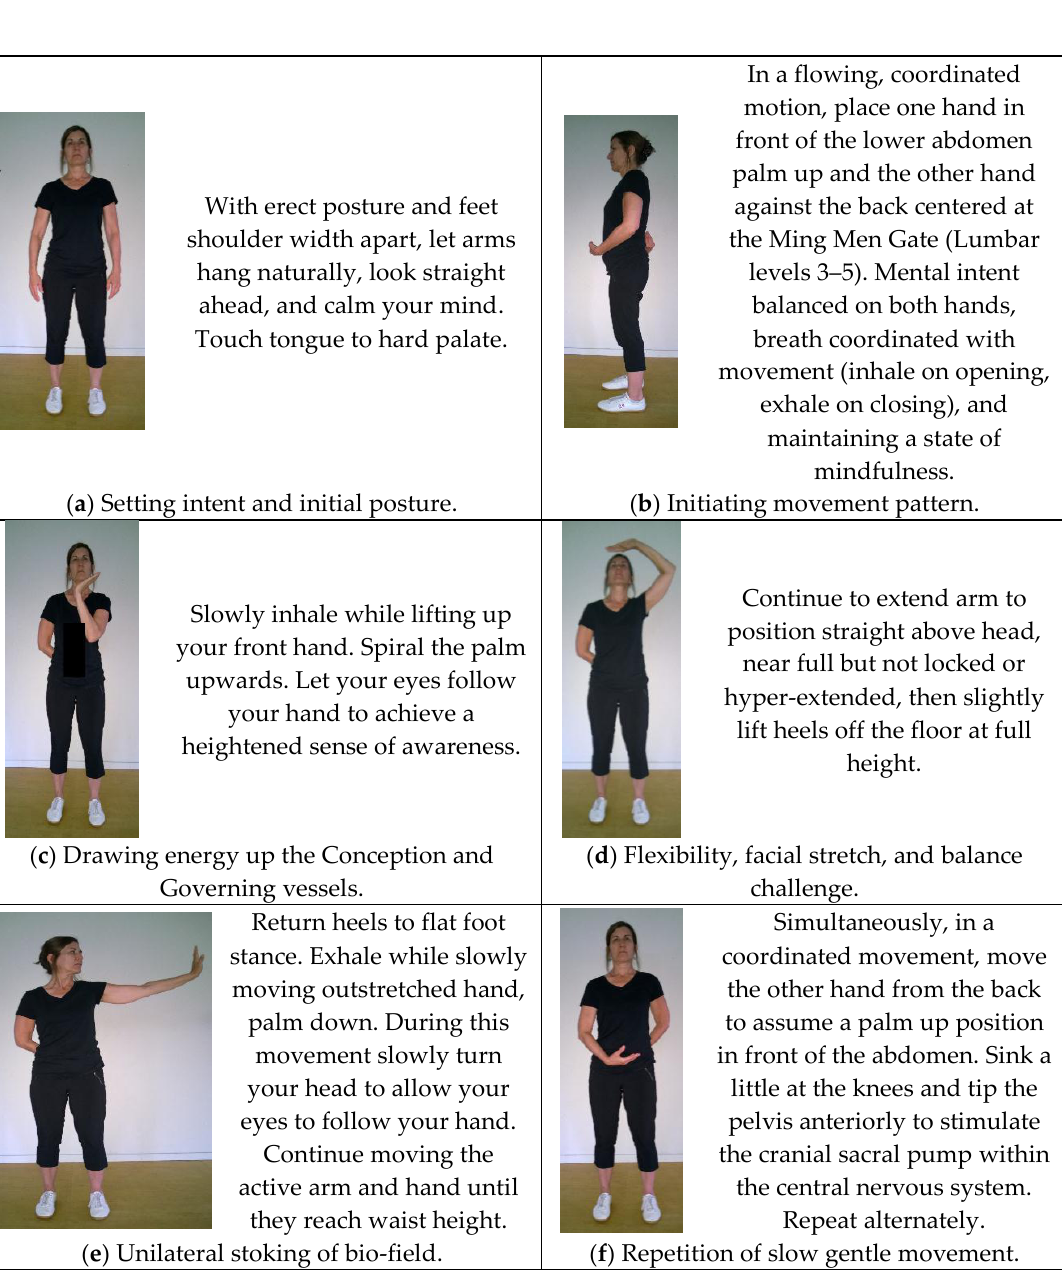
Figure 2. ‘Plucking the Stars’. Intent and purpose of the exercise progression as well as performance instructions are provided within the illustrations.